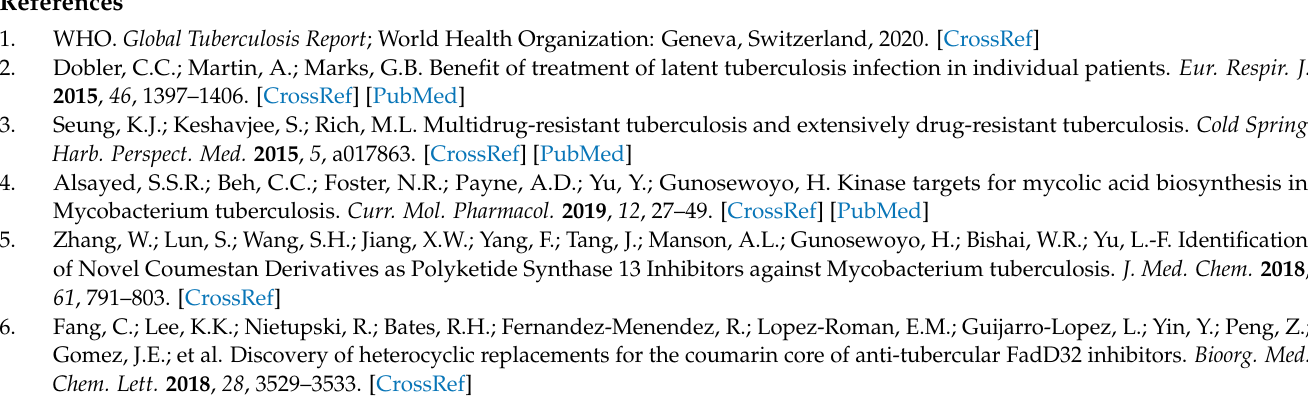
Table S4: RMSD (Å) values and